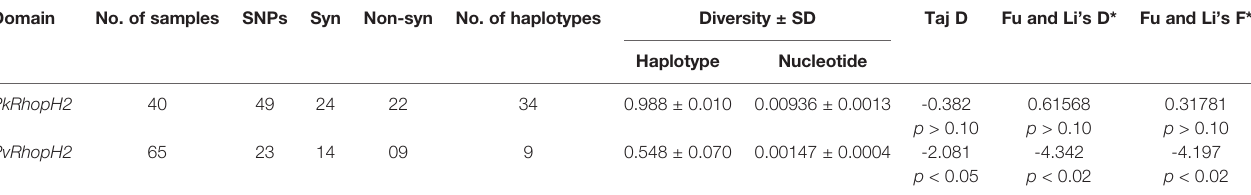
TABLE 1 | Estimates of nucleotide diversity, haplotype diversity, and neutrality indices of P knowlesi and P. vivax RhopH2 genes. Domain No. of samples SNPs Syn Non-syn No. of haplotypes